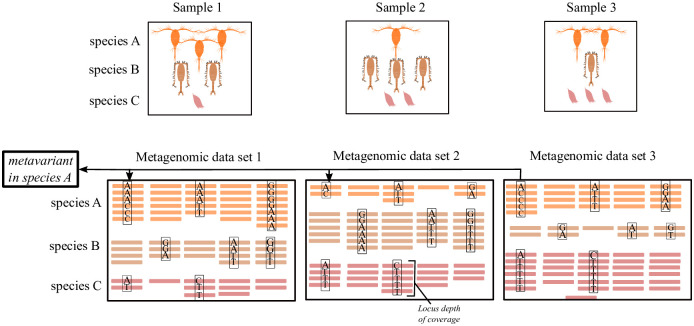
Metavariants from environmental samples and metagenomic high-throughput sequencing.The example contains three different species. Species A generates orange reads, species B brown reads and species C red reads.